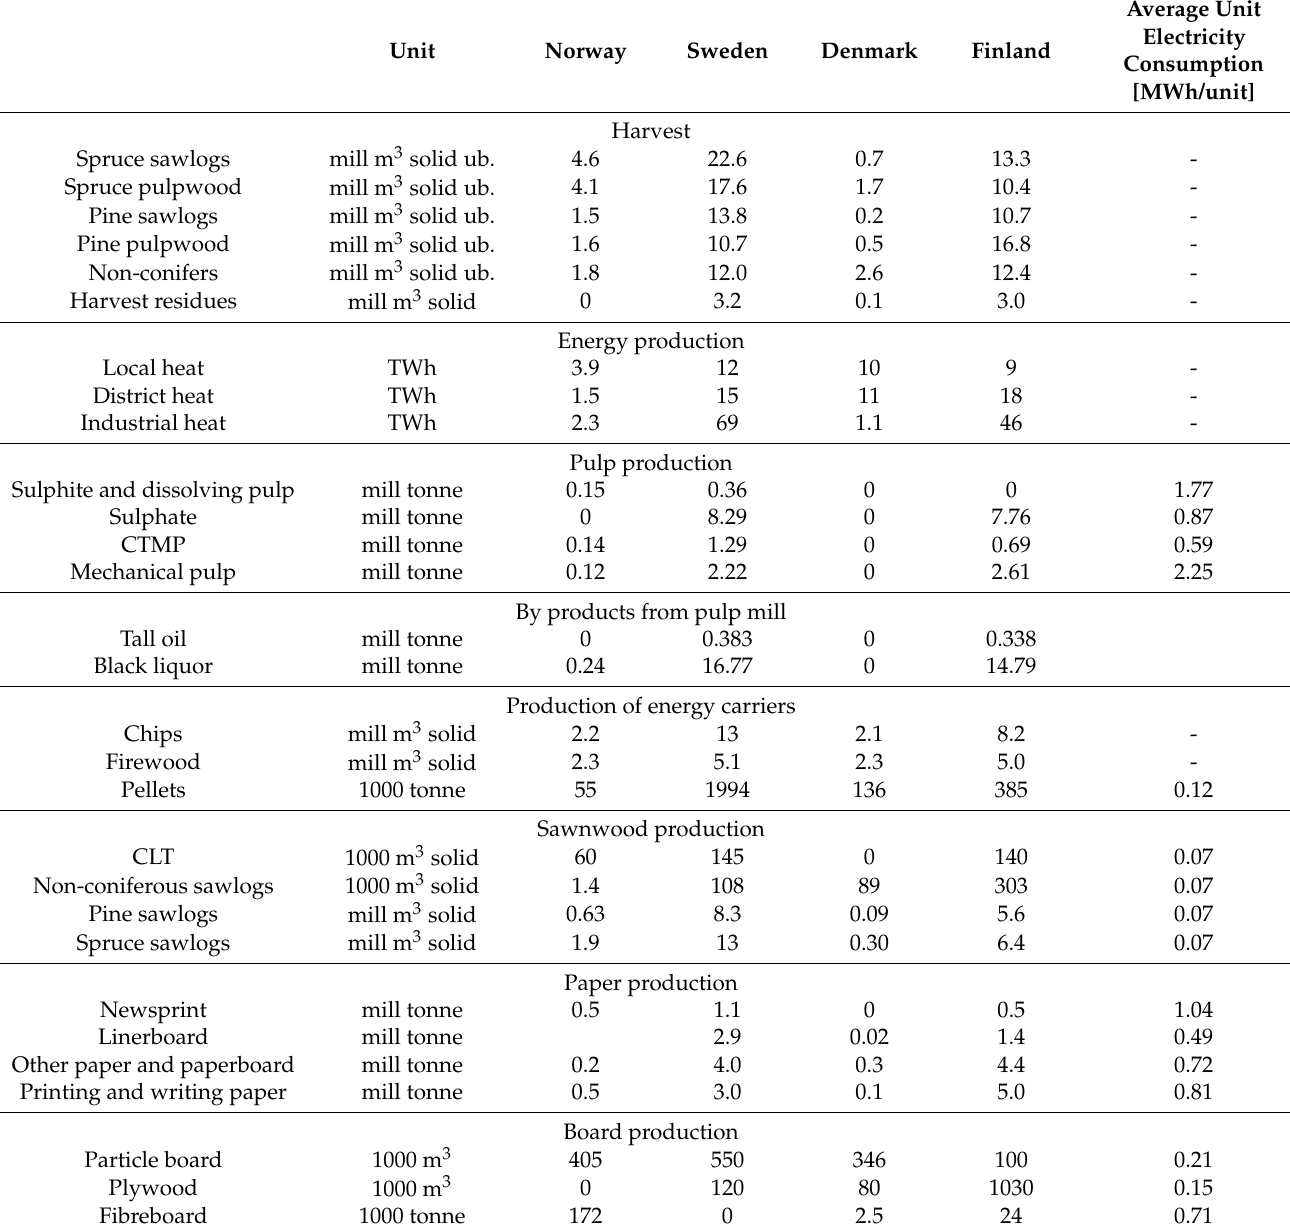
Table 1. Harvest, industrial production and unit electricity production in in the base year (2018). Source: